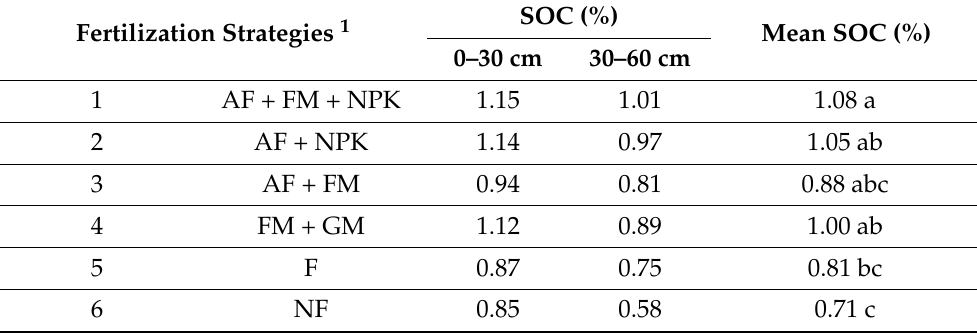
Table 5. Influence of different fertilization strategies on SOC concentrations (%) of vineyards (0–30 cm and 30-60